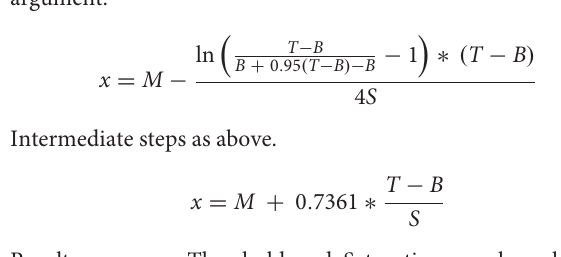
FIGURE 4 | Fitting different Boltzmann sigmoidal functions to real cardiac baroreflex data. Sigmoidal curve fitting to real data from a previous study (Heusser et al., 2016) and illustration of related terminology. After fitting the four parameters of three different equations to these data the resultant function curves overlap exactly. The slope triangle denotes the maximum slopes of the three sigmoidal curves at their inflection point. See Results “Curve fitting by means of the modified Boltzmann sigmoidal equation to experimental data” for more